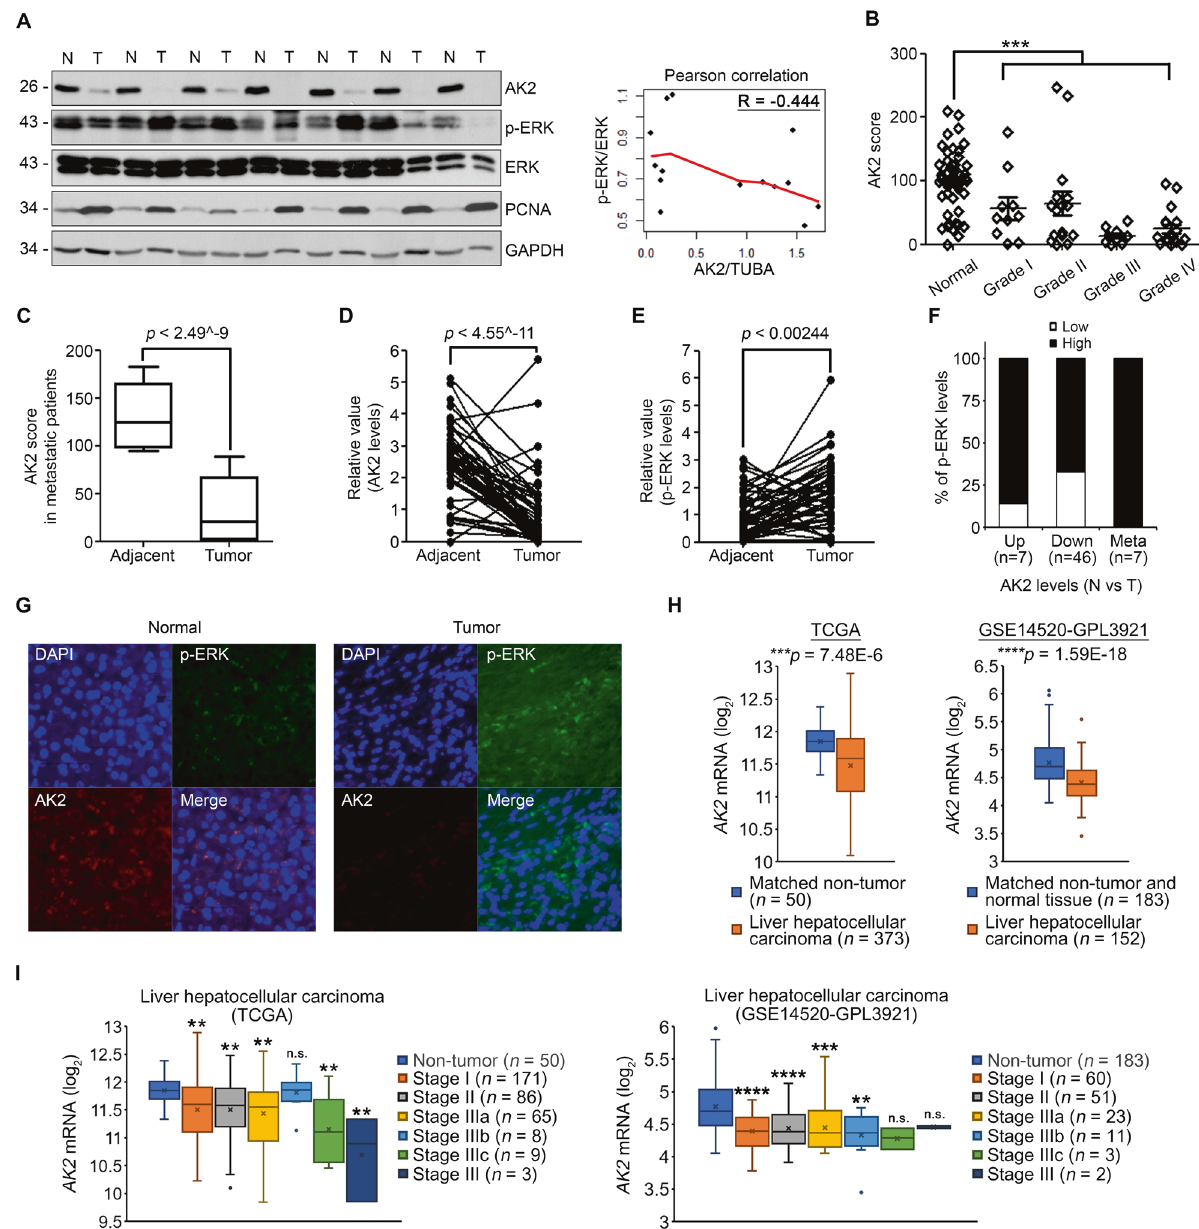
Fig. 4 AK2 loss and ERK1/2 phosphorylation show an inverse correlation in human HCC patients. A Loss of AK2 correlates with increased p-ERK level in series of human liver cancers. Tissue extracts prepared from liver tumors (T) and surrounding hepatic tissues (N) were examined with western blotting (left). Total GAPDH was used as a loading control. The graph shows Pearson correlation between fold changes of AK2/ TUBA and p-ERK/ERK levels (right). B Quanti fi cation of relative AK2 levels in (A). Each symbol represents an individual patient. ( n = 53; *** p < 0.001). C Differences in AK2 level, as in ( B ), according to metastatic state of human liver tumors (by Mann – Whitney U test). Data are presented as Turkey box-and-whisker plots. Values are presented as mean ± SD ( n = 53; **** p < 0.0001). D , E Statistical analysis showing relative levels of AK2 and p-ERK in 53 paired tumor and adjacent samples. Statistical analysis was performed by paired Student ’ s t-test. Values are presented as mean ± SD ( n = 53; * p < 0.05, ** p < 0.01, *** p < 0.001, **** p < 0.001). F Summaries of AK2 expression pro fi le and inverse correlations between AK2 expression and p-ERK level in liver specimens. Data were fi rst organized by AK2 expression levels (Up, Down) in tumors compared to adjacent tissues and then further separated into two categories according to p-ERK levels (Low, High) in tumors. In addition, metastasized HCC tissues, which had shown signi fi cant reduction in AK2 levels, were also analyzed as separated category. G Immunohistochemistry with anti- AK2 and anti-p-ERK antibodies was performed on the paraf fi nized-tissue slides and observed under confocal microscope. H Comparison of AK2 expressions in HCC patient samples. HCC datasets (TCGA-LIHC and GSE14520-GPL3921) containing microarray data were analyzed for their AK2 mRNA expressions between tumor and the matched non-tumor tissues. Box-and-whisker plots were statistically analyzed by paired Student ’ s t-test (* p < 0.05, ** p < 0.01, *** p < 0.001, **** p < 0.0001). I HCC datasets from ( H ) were sorted by tumor stages. P values were obtained by one-way analysis of variance (ANOVA) followed by Dunnett ’ s test for multiple comparison (* p < 0.05, ** p < 0.01, *** p < 0.001, **** p <